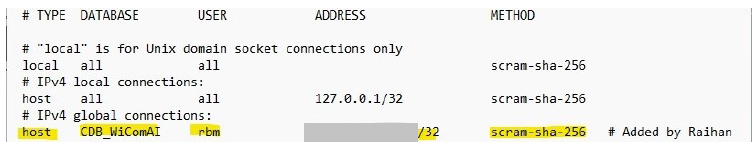
Figure 14. Restricting unauthorized access to the global database.